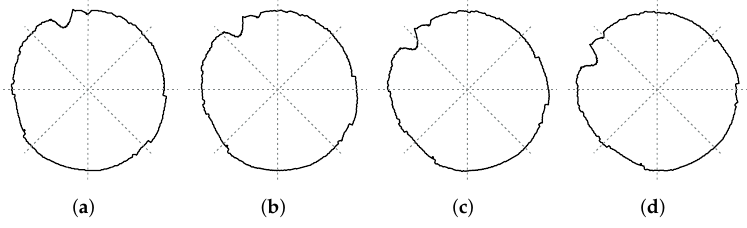
Figure 15. Rotation examples of the second circle of M2: ( a ) 0 ◦ , ( b ) 15 ◦ , ( c ) 30 ◦ , and ( d ) 45 ◦ .